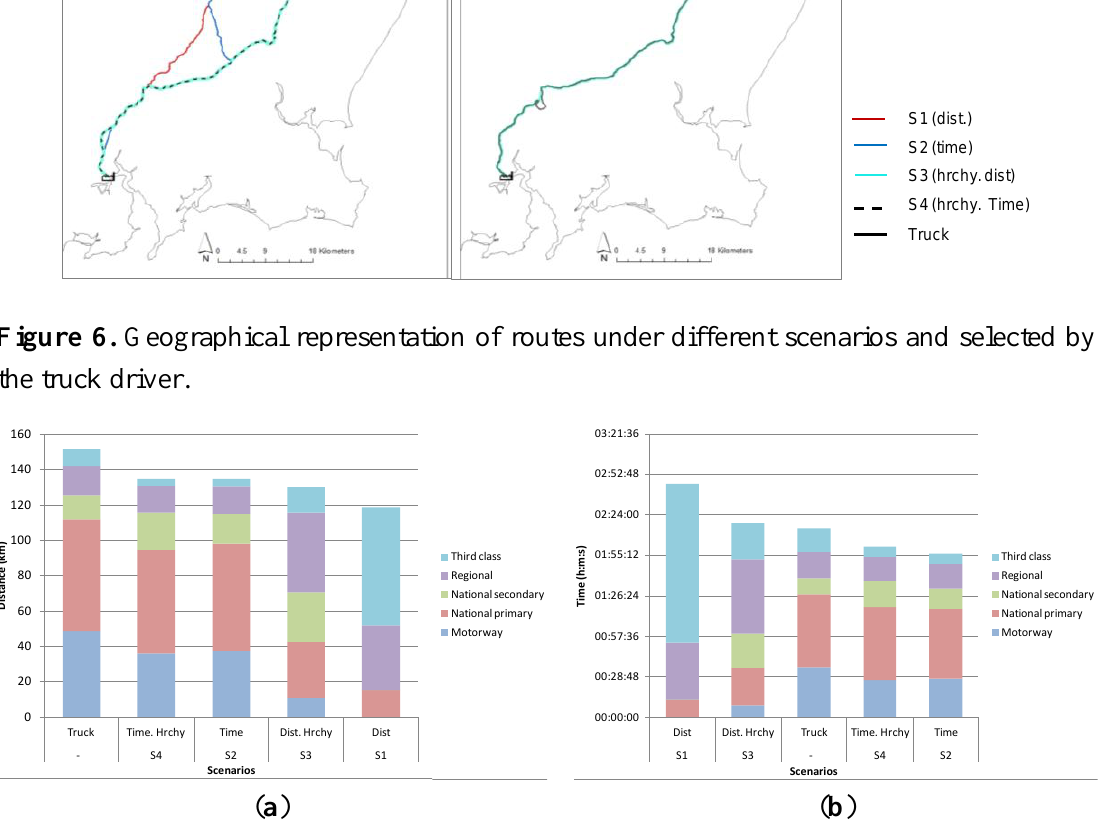
Figure 7. Different proportions of road types by routes under different scenarios: ( a ) by distance; ( b ) by